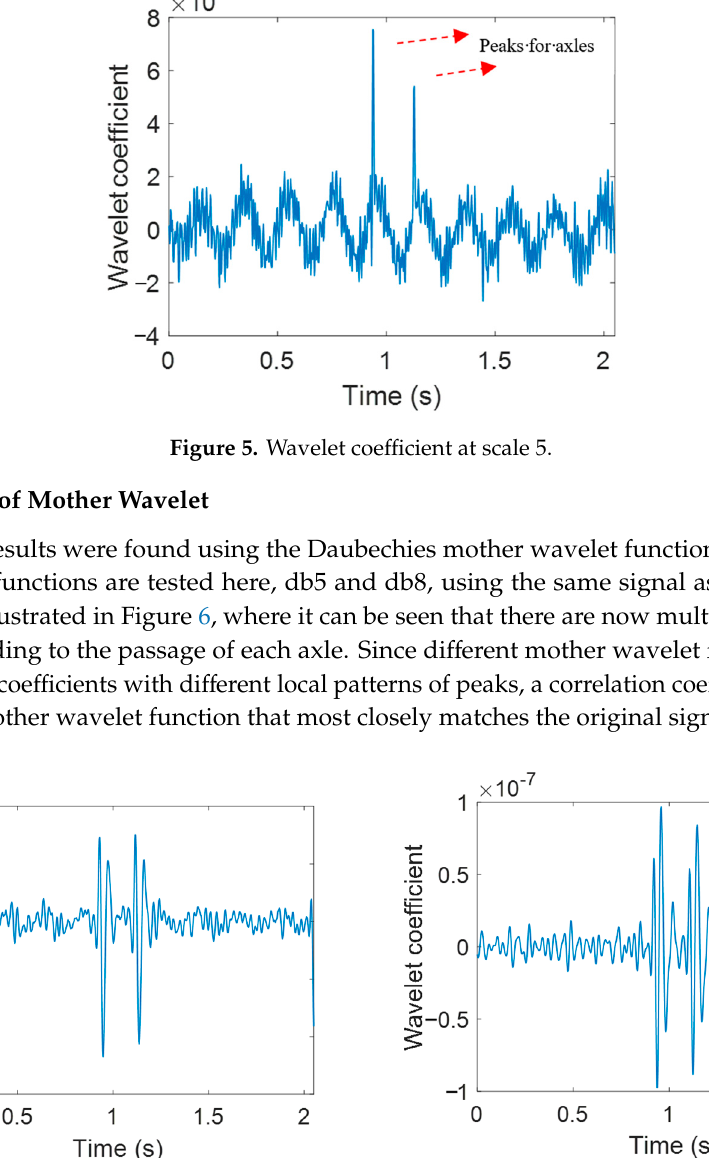
Figure 7. Correlation coefficient for different mother wavelet functions.